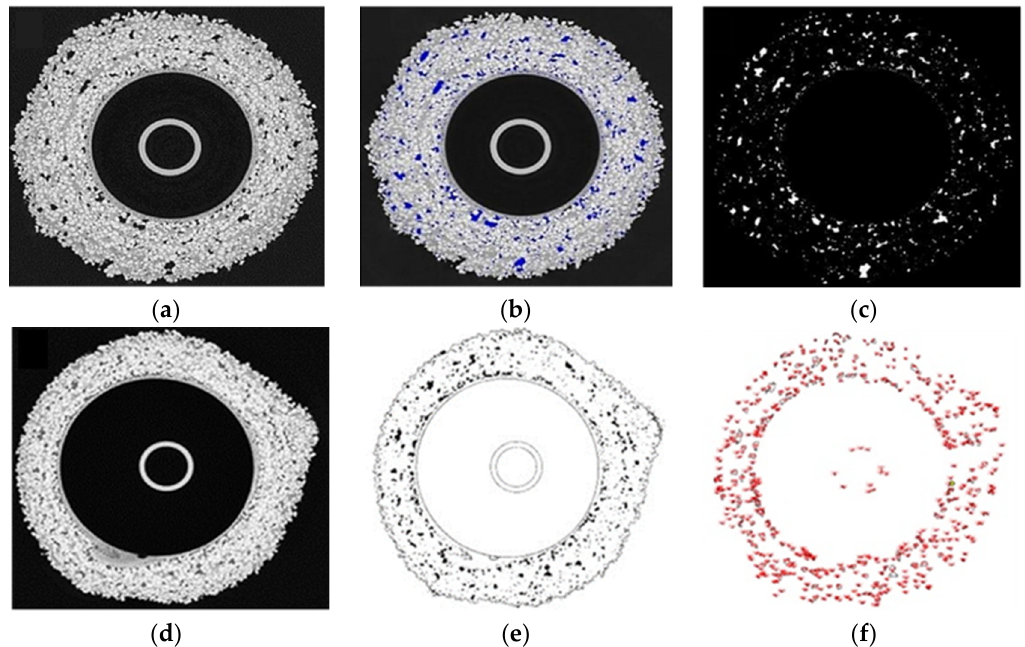
Figure 5. Tomographic image of a spherical sample: immediately after the test ( a ), after exposing the porosity ( b ) and after extracting only the porosity ( c ). Methodology for determining the approximate percentage of the sample’s porosity based on image recognition methods in Fiji: cross-sectional image obtained from the tomograph ( d ), thresholding ( e ) and calculation of porosity (after separation of elements >1 px) ( f ).